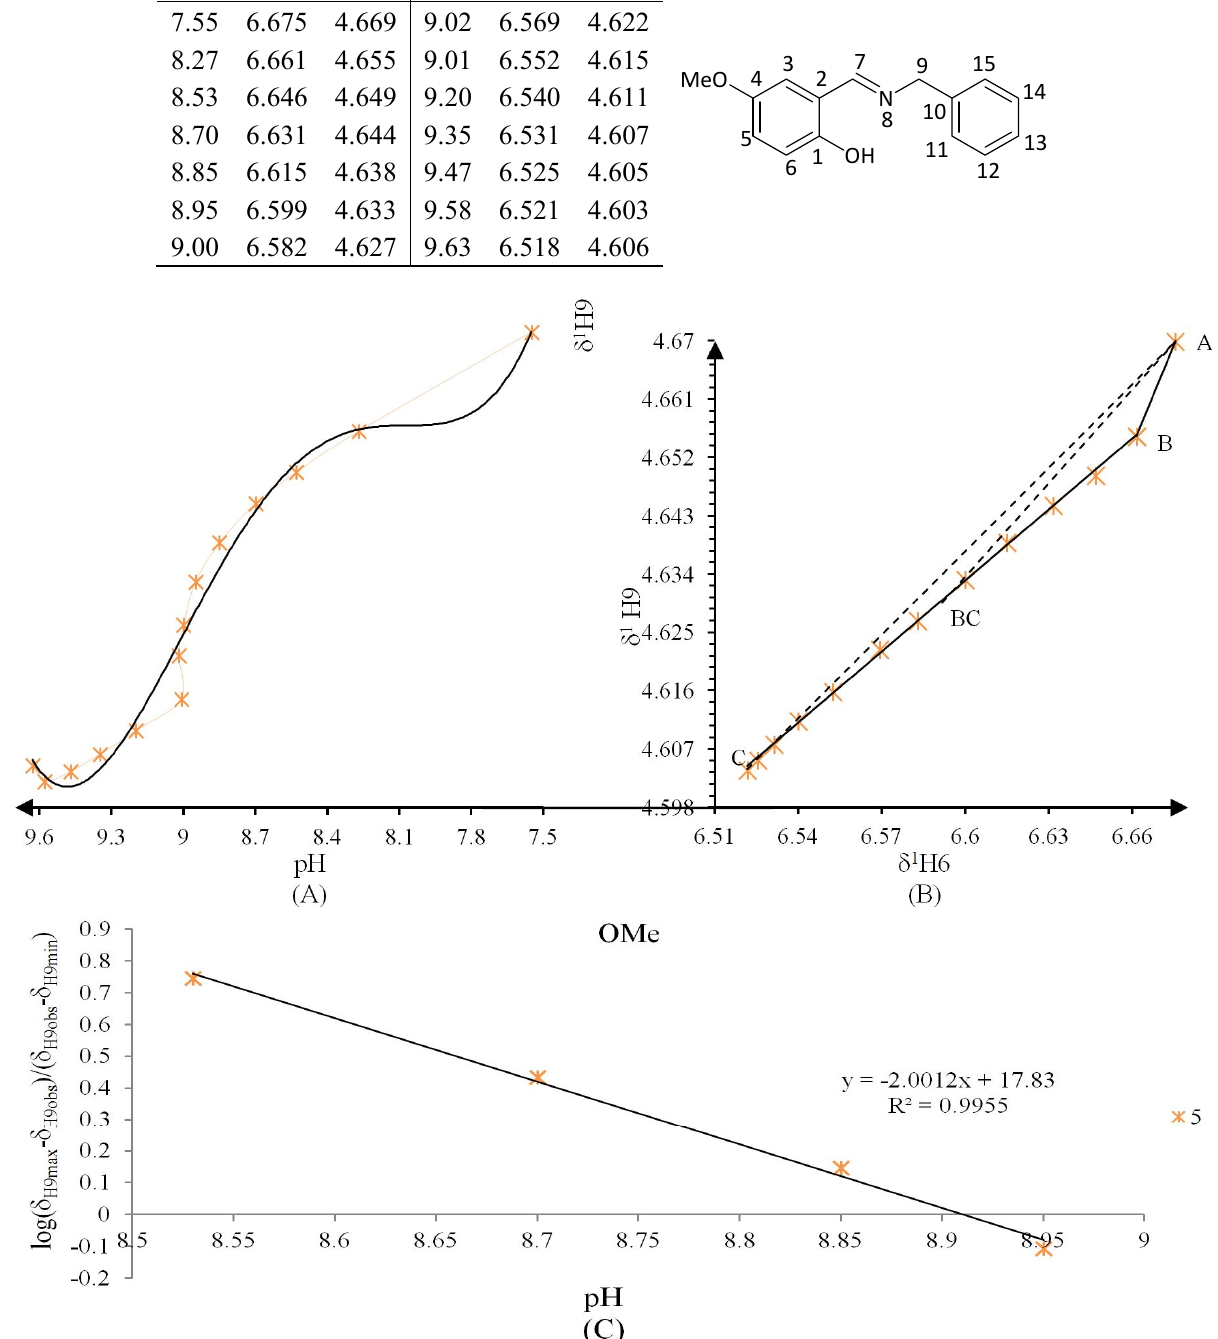
Figure 10. ( A ) titration curve (pH vs. δ 1 H9); ( B ) δ -diagram with Polster-Lachmann analysis ( δ 1 H6 vs. δ 1 H9) and ( C ) plot of the semilogarithmic Henderson-Hasselbalch equation (pH vs. log[( δ − δ )/( δ − δ )]) of compound 5 (R = H9max H9obs H9obs H9min